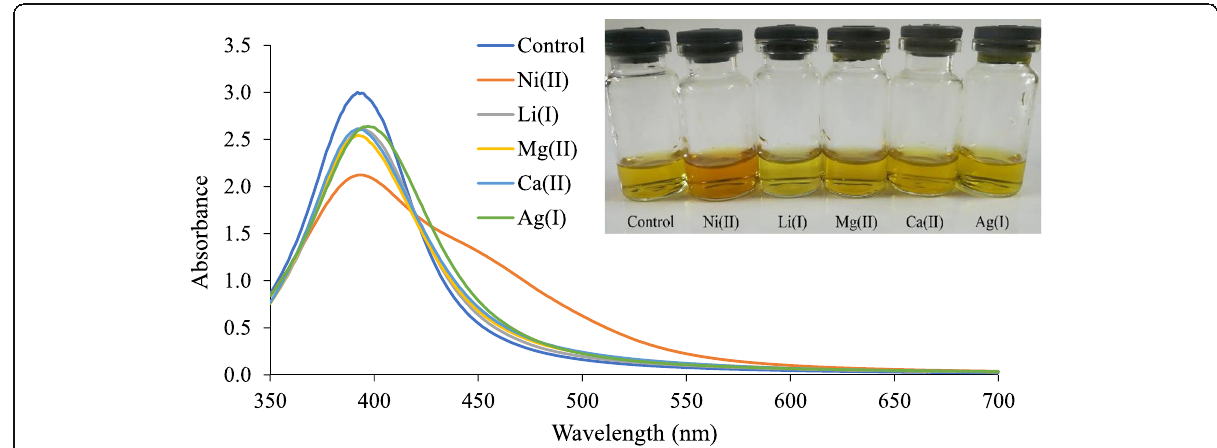
Fig. 8 Color and absorbance curve responses of the assay for various ions at 1 mM concentration of metal cation